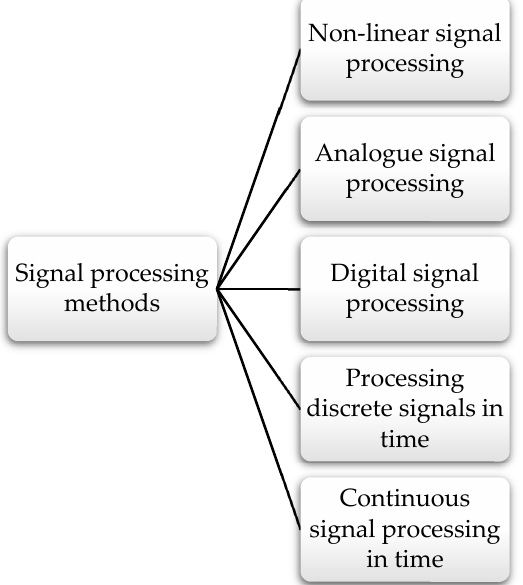
Figure 2. Classification of signal processing methods.